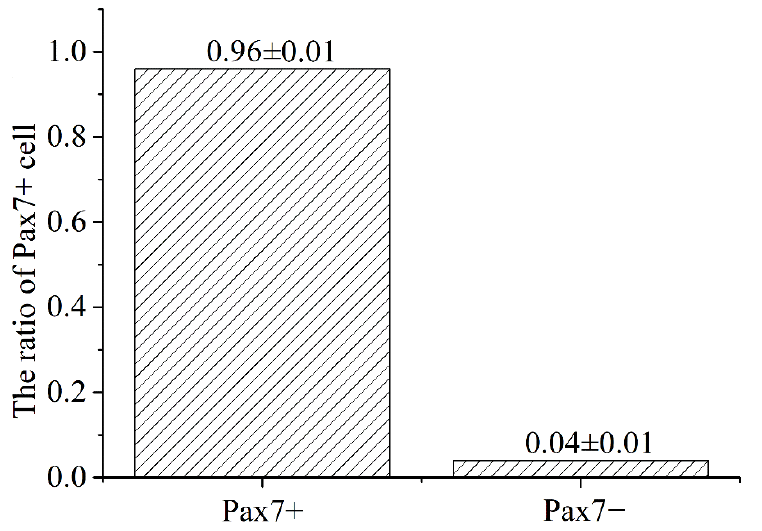
Figure 4. The effect of L-leu on the activity of equine SCs. The values with different small letter superscripts mean significant difference ( p < 0.05), and with different capital letter superscripts mean significant difference ( p < 0.01), while with the same or letter superscripts mean no significant dif- ference ( p > 0.05). 3.3. Differential Expression Analysis The expression of the mRNA transcripts in the equine SCs in response to the L-leu treatment (2 mM) is represented by a Volcano Plot (Figure S1), and their p -value and fold changes are listed (Supplementary Table S2). The differentially expressed mRNA met the